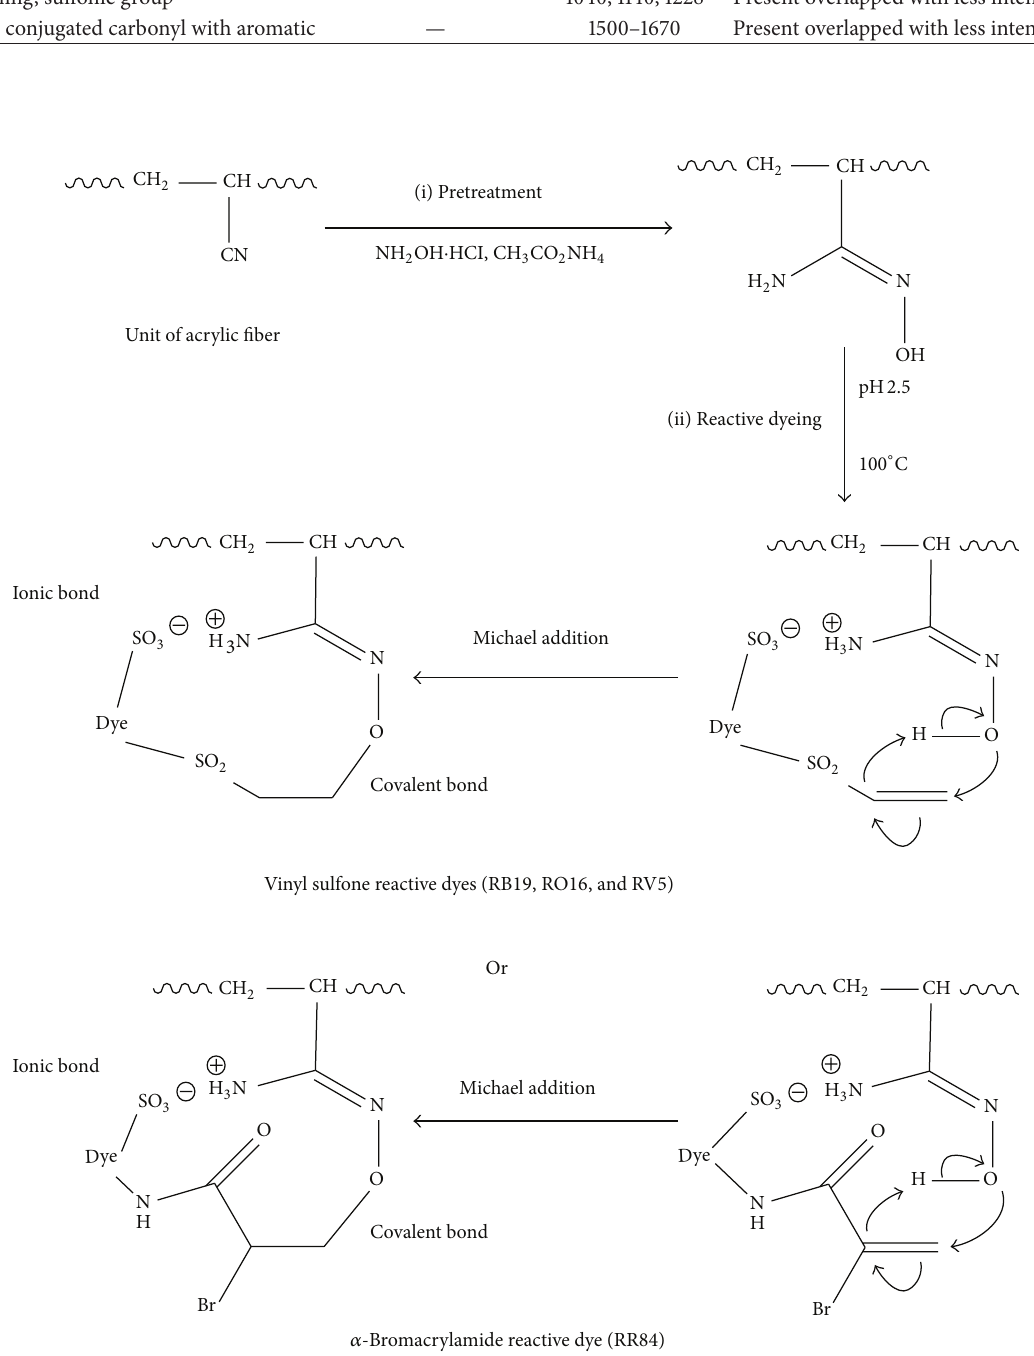
Figure 6: Fixation mechanism of reactive dyes on amidoximated acrylic